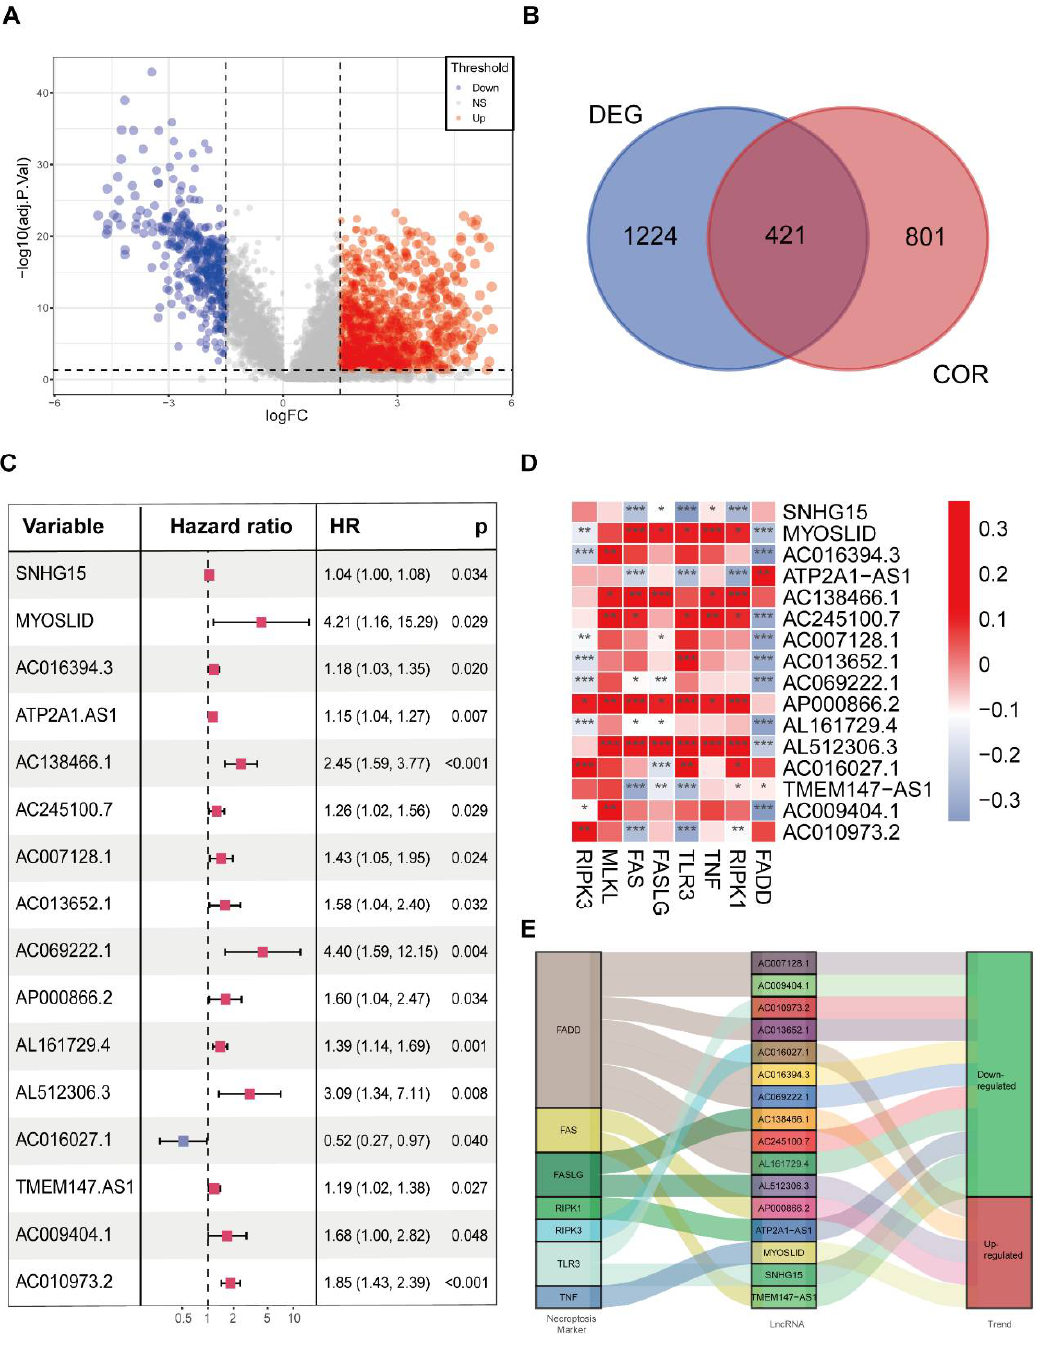
Figure 2. Prognostic evaluation of candidate necroptosis − related lncRNAs. ( A ) Volcano plots pre- senting the expression data of the 1645 differentially expressed lncRNAs in CRC patients from the TCGA − COAD cohort. ( B ) Venn diagram depicting the common collections of differentially ex- pressed lncRNAs (DEGs) and necroptosis − related lncRNAs (CORs). ( C ) Cox univariate regression analysis of 16 candidate necroptosis − related lncRNAs. Red squire: Hazard ratio > 1, Blue squire: Hazard Ratio < 1( D ) Heatmap showing the correlation between the levels of the 16 prognostic necroptosis − related lncRNAs and 8 validated hub genes in the necroptosis pathway in CRC pa- tients. The colour of the blocks shows the degree of correlation. * p value < 0.05, ** p value < 0.01, and *** p value < 0.001. ( E ) The Sankey diagram presents the detailed connection between necropto- sis − related lncRNAs and necroptosis − related genes.